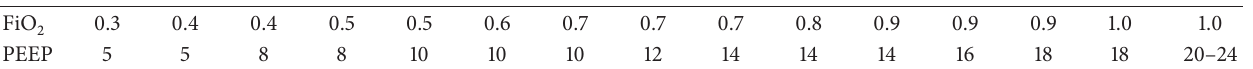
Table 2: Sliding scale of PEEP/FiO 2 combinations to maintain oxygenation. Positive end-expiratory pressure (PEEP) represents the level set at ventilator and not levels of total PEEP, auto-PEEP, or intrinsic